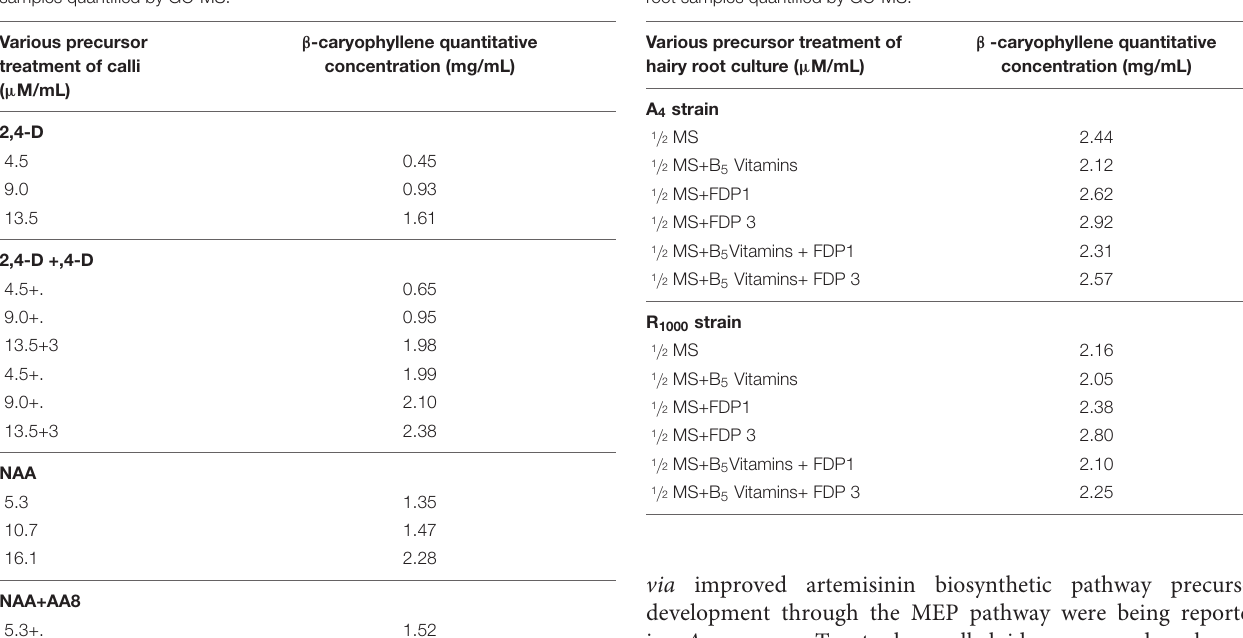
β -caryophyllene quantitative concentration